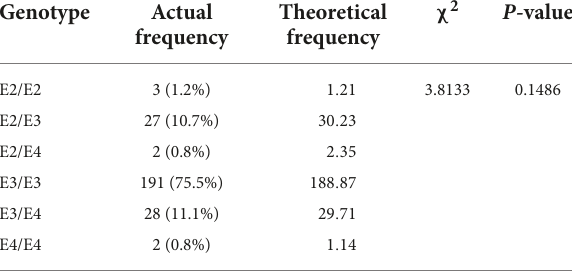
TABLE 1 The Hardy-Weinberg genetic balance test of the APOE